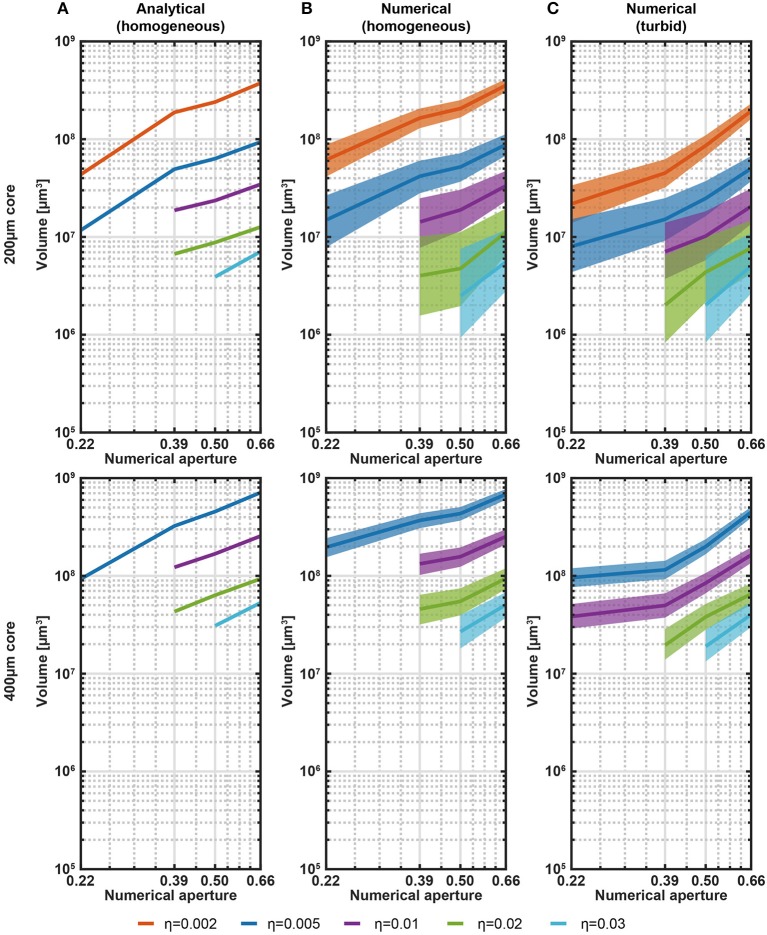
Analytical and numerical estimation of collection volumes. (A) Volume iso-surfaces at different η estimated with the analytical model in transparent medium as a function of NA. Data are shown for η = 0.002, 0.005, 0.01, 0.02, 0.03 and for fibers with core/cladding diameters a/b = 200 μm/225 μm, 400 μm/425 μm (top and bottom panels, respectively). Missing data at low NA means null volume. (B) Same analysis of (A) shown for the ray-tracing model in transparent medium. The width of the curves represents the error in the volume estimation introduced by the domain discretization. (C) Same analysis of (B) shown for the ray-tracing model in a turbid medium to simulate brain tissue. Scattering was modeled with Henyey-Greenstein formulation (n = 1.360, l = 48.95 μm, g = 0.9254, T = 0.9989). The width of the curves represents the error in the volume estimation introduced by the domain discretization.